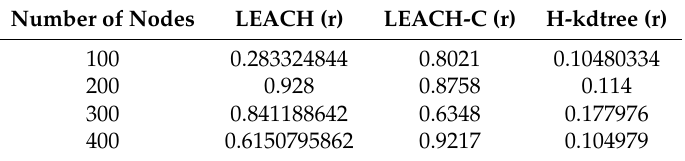
Table 13. Delay (seg). (r)